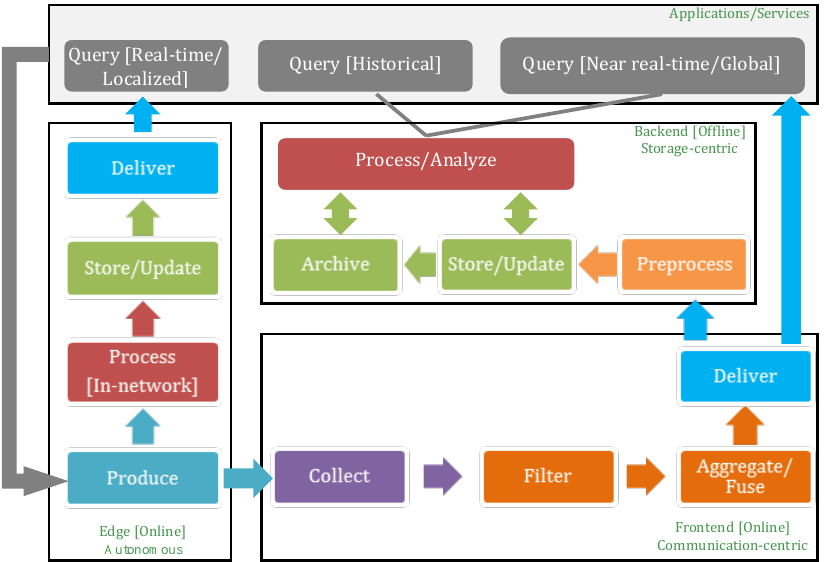
Figure 1. IoT data lifecycle and data